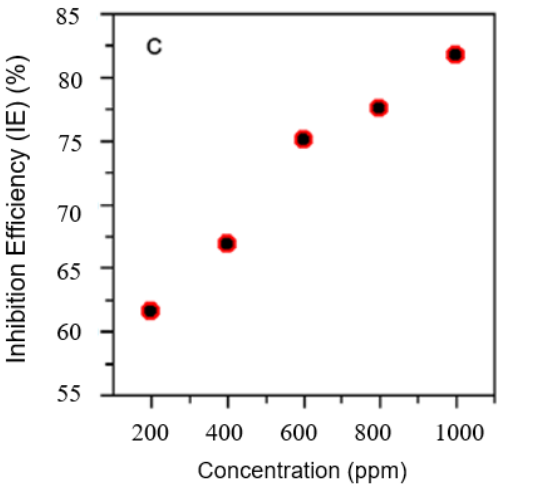
Figure 4. The relationship between concentration and inhibition efficiency. Reprinted from [78].